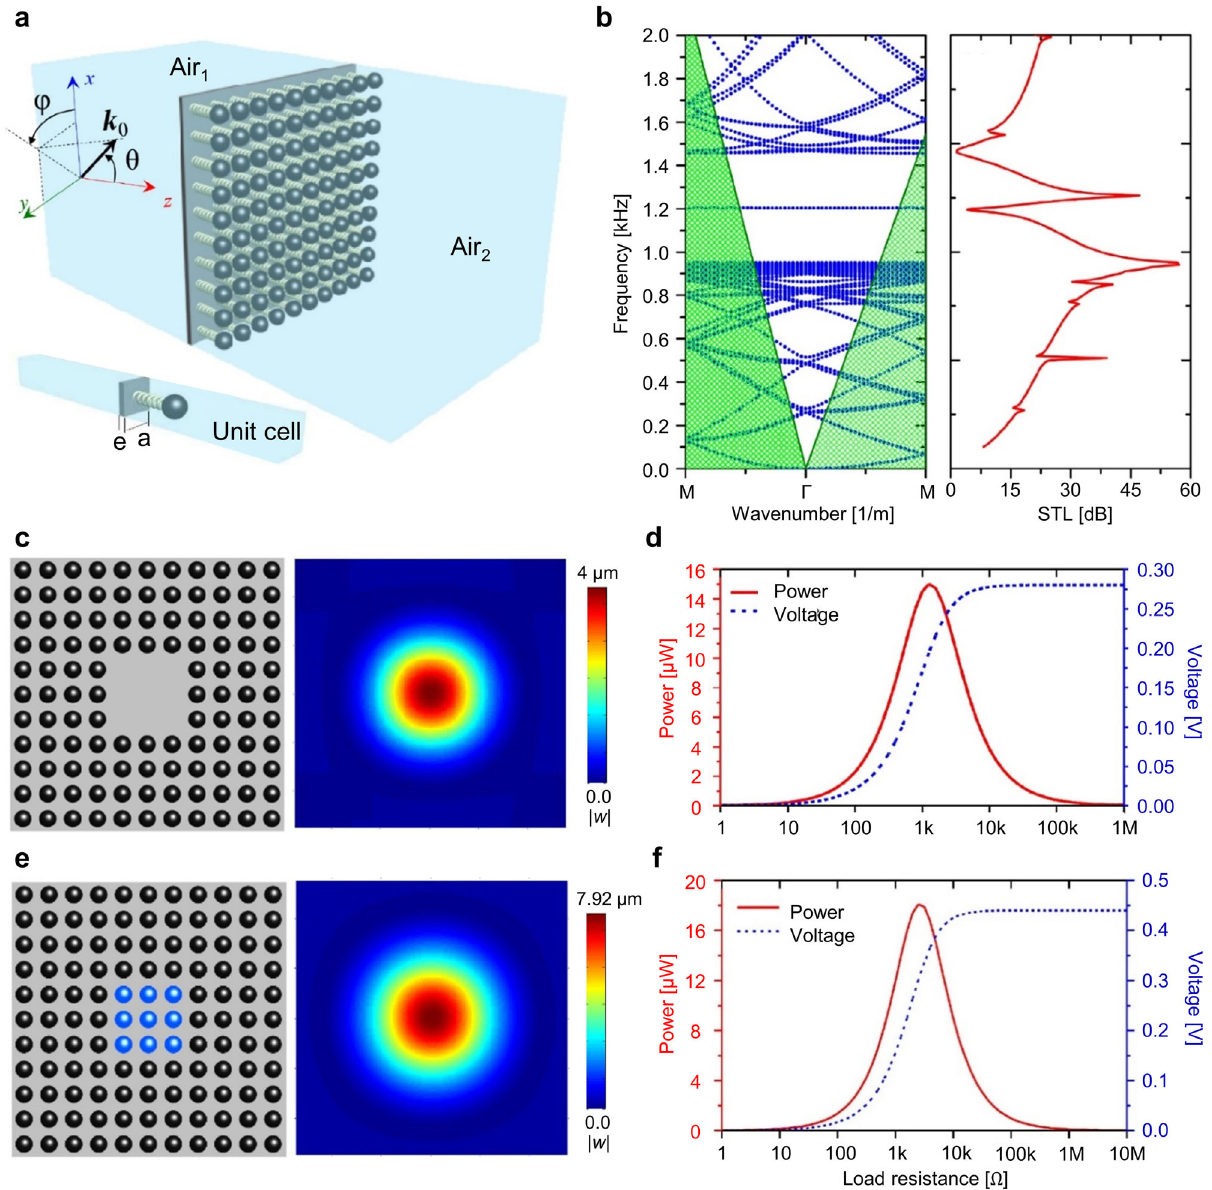
Fig. 4 Tunable subwavelength acoustic metamaterial (MM) plate for energy harvesting. a Simpli fi ed model of MM plate. The unit cell is composed of a spring-mass resonator and a thin plate, while the supercell MM plate is made up of a square array of unit cells; k 0 : wavevector, θ : elevation, and φ : azimuth angle. Acoustic waves propagate from Air 1 to Air 2 through the MM plate. Supercell of the MM plate structure where the defect is obtained b by removing the nine central resonators and c by changing the stiffness of the nine central resonators and each displacement fi eld of the plate at the defect mode frequency. The spring-mass resonators and stiffness changed resonators are described as black and blue spheres, respectively. d Calculation of the band structure and sound transmission loss (STL) about the supercell with removing nine central resonators. The edge of the green shaded region in the band structure symbolized the sound line, which determines whether airborne sounds can be radiated or not; hence, propagation modes are not permitted in the shaded region. Output power and voltage of MM plate structure e by removing the nine central resonators and f by changing the stiffness of the nine central resonators, at the frequency of the defect mode 75 . Reprinted with permission from ref. 75